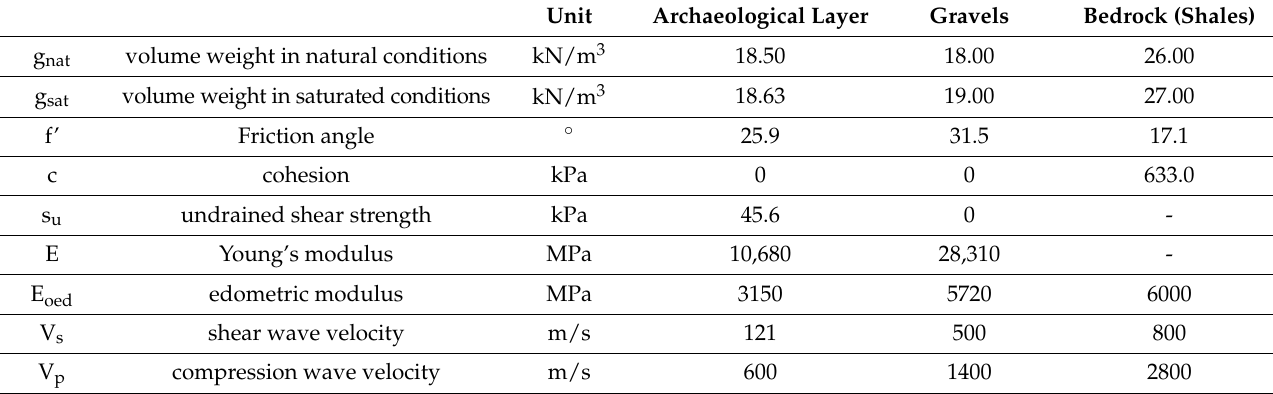
Table 2. Site geotechnical data for subsoil of the Arnolfo’s Tower.